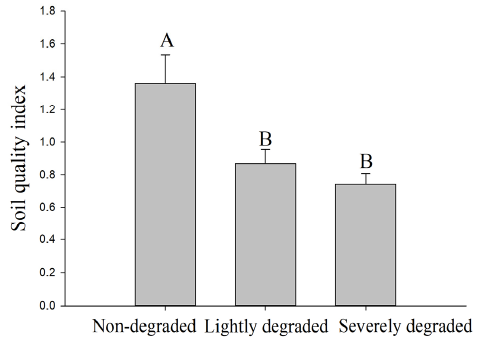
Figure 6. Soil quality index after vegetation restoration and AMF inoculation. Different letters indicate the significant differences among treatments ( p < 0.05). Table 3. Principal component analysis of soil quality indicators.